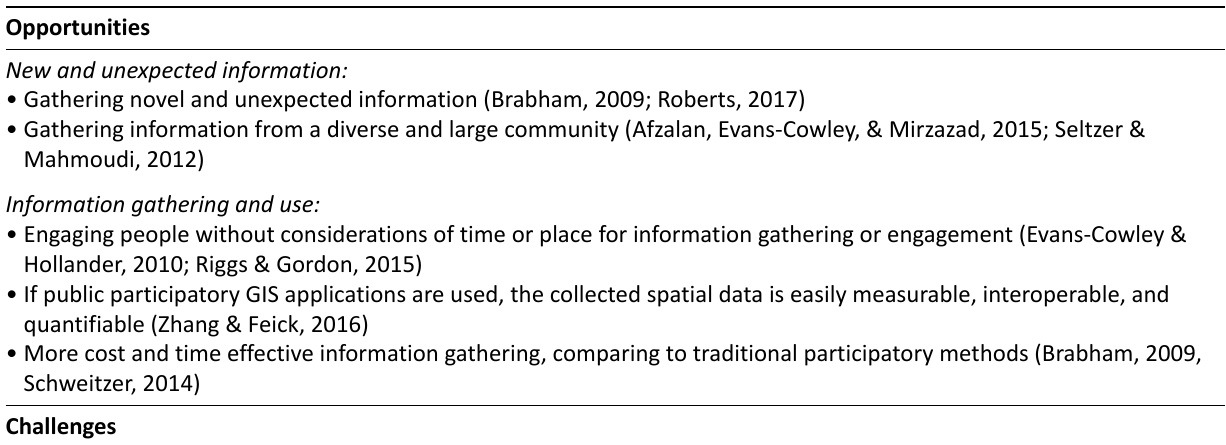
Table 1. Opportunities and challenges of crowdsourcing information in